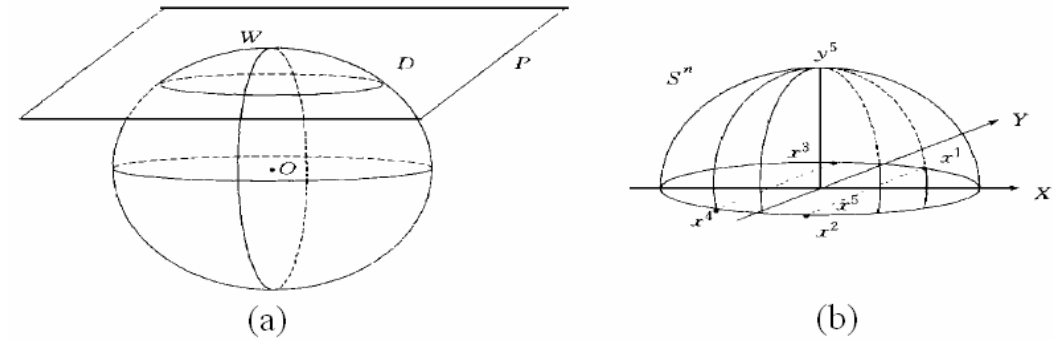
Figure 7. (a) a sphere neighborhood (b) input vector and their